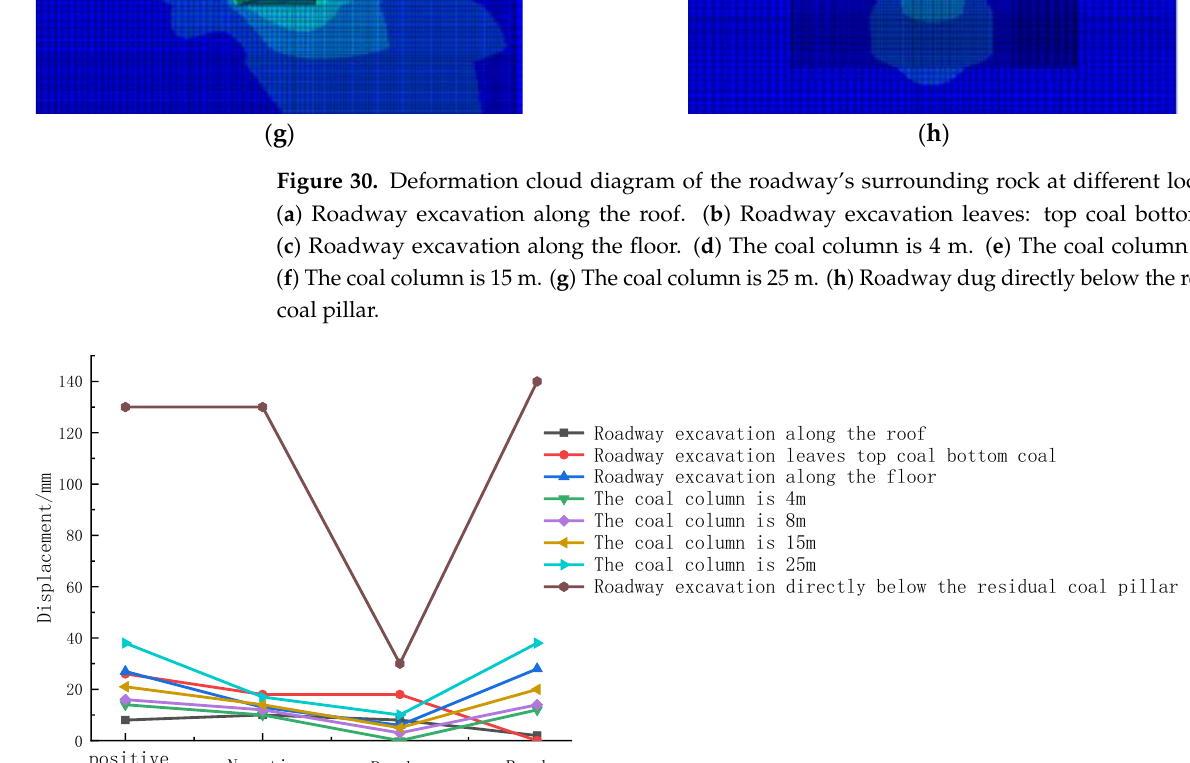
Figure 31. Deformation curves of the roadway ’s surrounding rock at different locations.